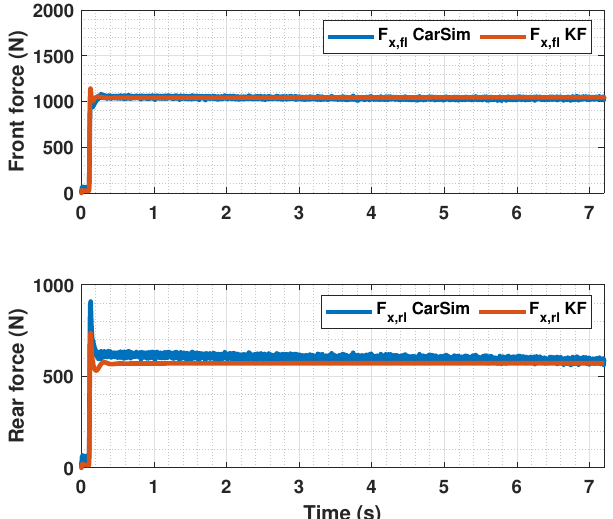
Figure 13. Estimated forces by KF compared with CarSim forces for µ max =